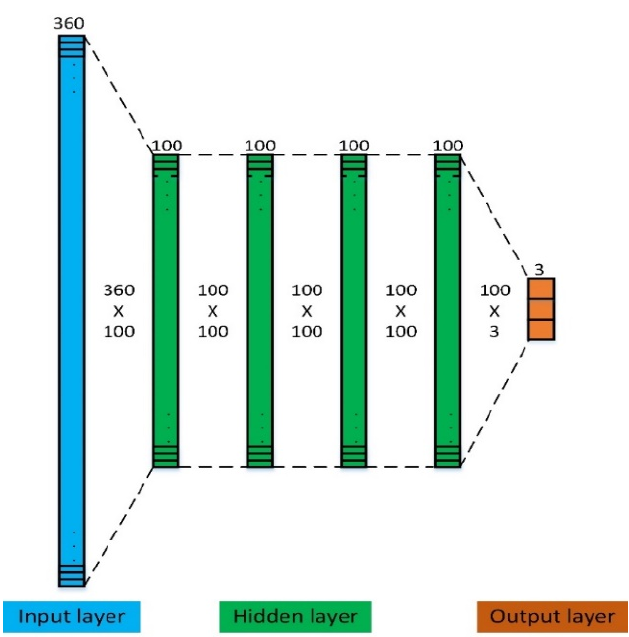
Figure 7. Schematic illustration of the Double-DQN network. Table 2. List of hyperparameters and their values.